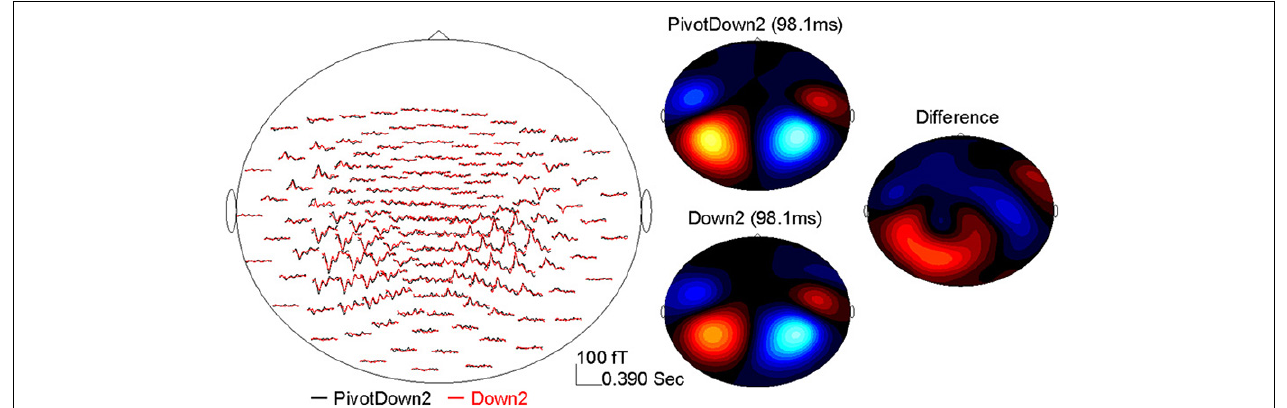
FIGURE 3 | Example of the AER (0–390ms) at the MEG sensor level after the down-beat onset in the PivotDown2 in the hemiola and Down2 in the march conditions. The left panel shows the grand-averaged response in